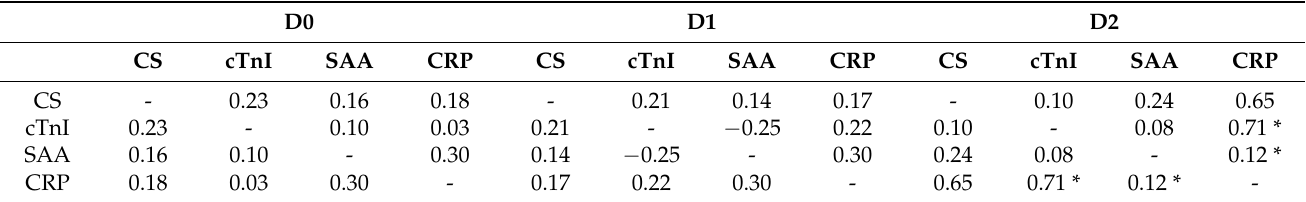
Table 3. Statistical correlations (r) among CS, cTnI, SAA, and CRP at D0, D1, and D2.